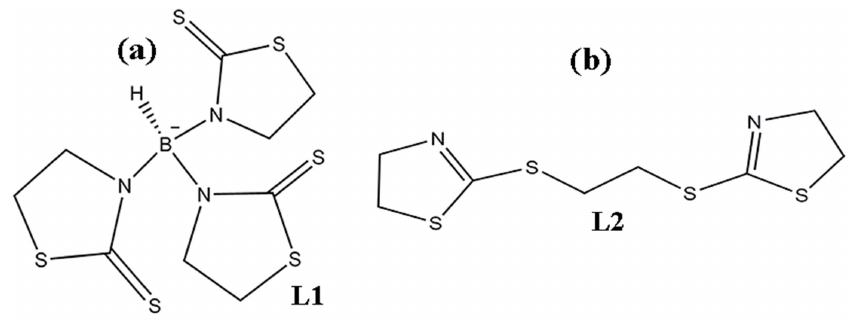
Figure 1 - Chemical structure of ligands. (a) l1 and (b)